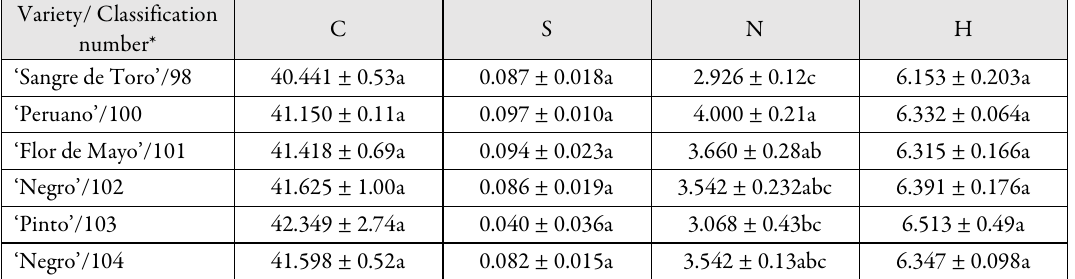
Table 7. C, S and N concentration (%) in common bean varieties produced in Morelos State, Mexico Variety/